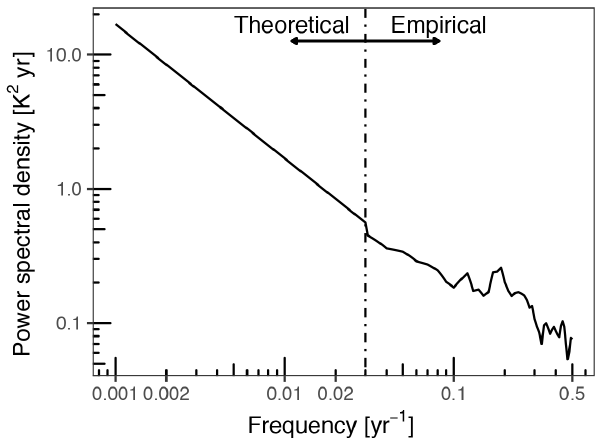
Figure 2. An example spliced empirical and power-law power spec- trum of ocean temperature (0–120m water depth) for 20 ◦ N latitude. A small discontinuity at ν = 0 . 03 is visible, since to increase the ro- bustness of the intercept estimate, the splicing is implemented by matching the integrated spectra between ν = 0 . 03 and ν = 0 .